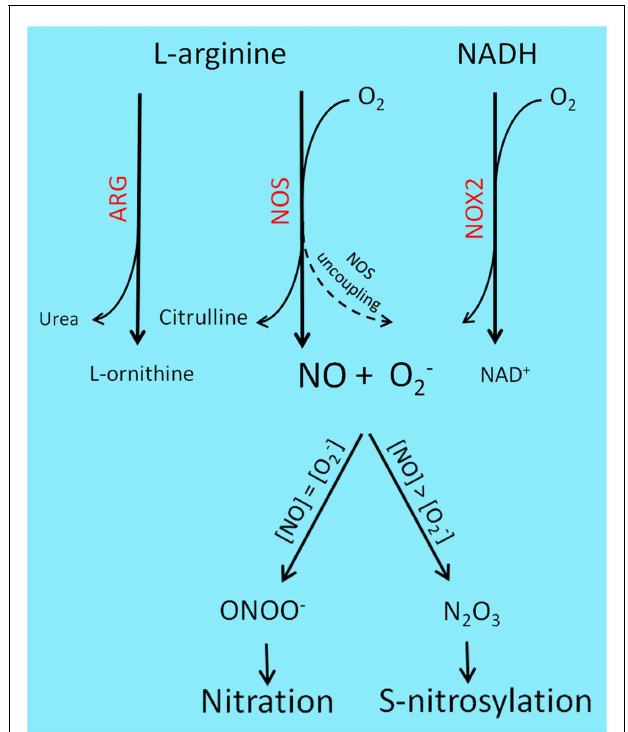
FIGURE 1 | Reactive nitrogen species-generating chemistry and PTM